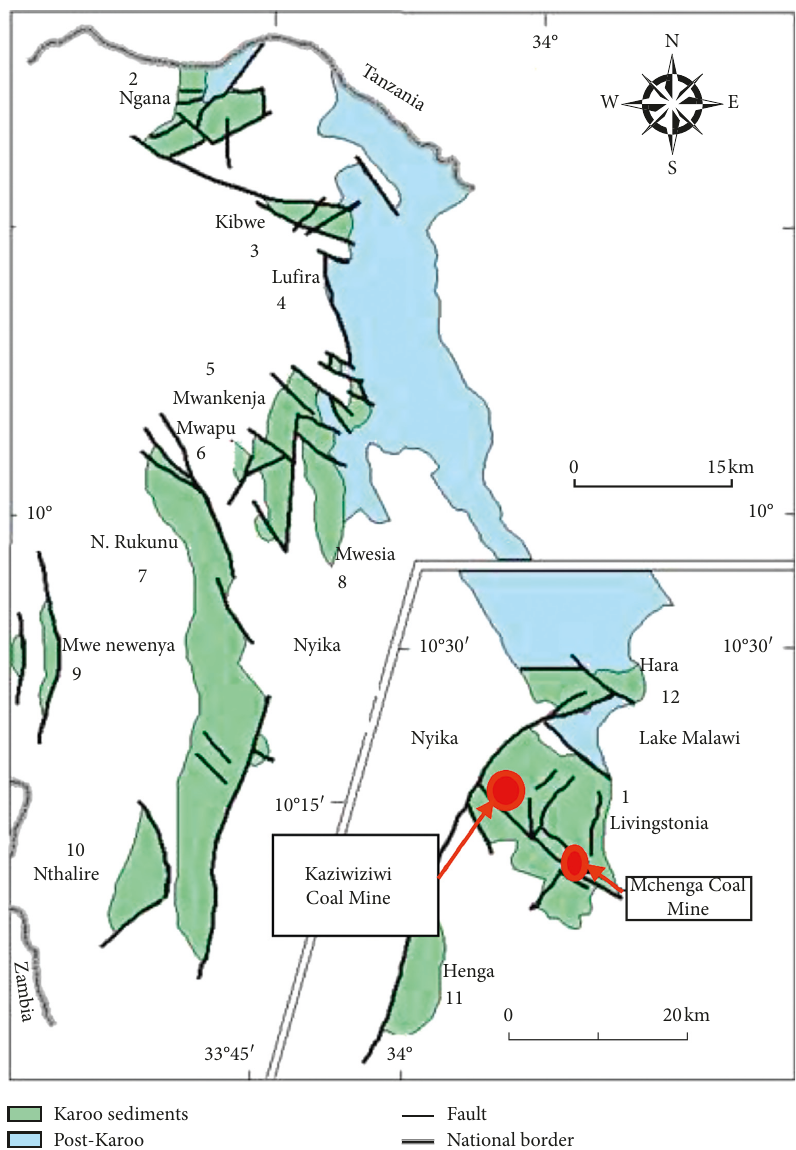
Figure 1: Distribution of Karoo basins in northern Malawi: North Nyika Basins and Livingstonia Basin (inset) based on an internal report at the Geological Survey Department in Zomba,